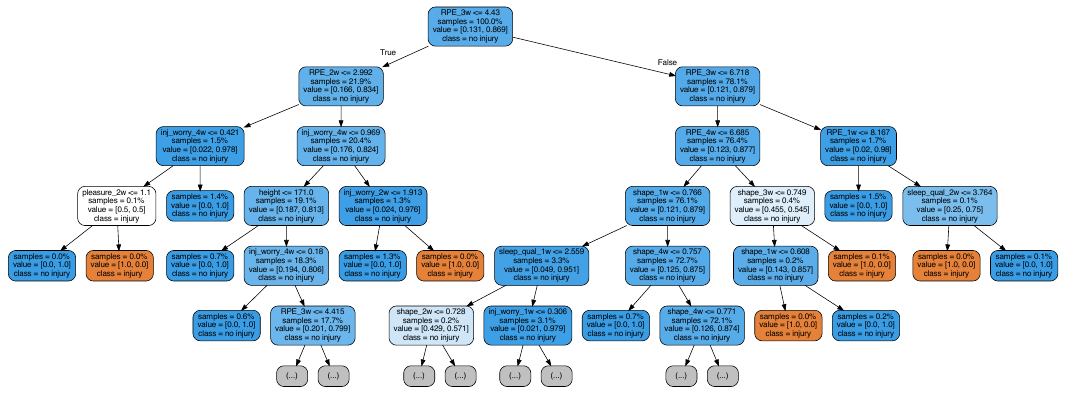
Figure 6. Decision tree learnt on questionnaires dataset for one-month injury prediction optimised for precision